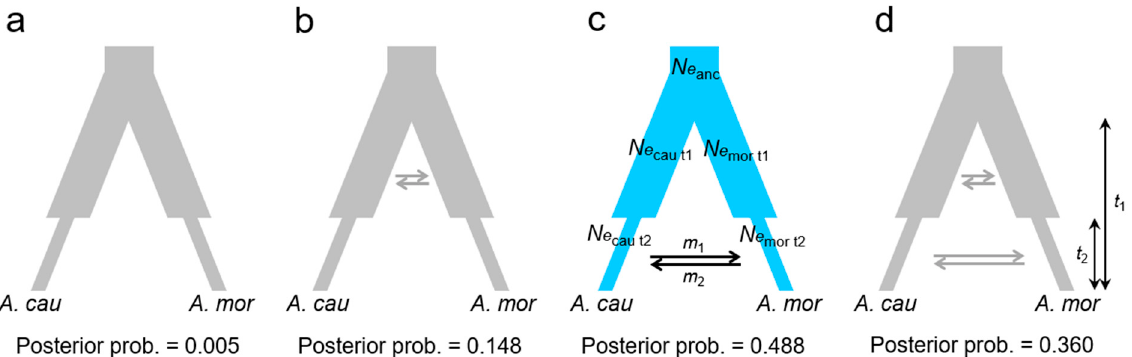
Figure 3. Four evolutionary scenarios describe all possible situations of interspecific gene flow after species divergence, including ( a ) no gene flow ( SI ), ( b ) early ( AM ), and ( c ) recent interspecific gene flow ( SC ), and ( d ) continuous gene flow after speciation ( CM ). The branch thickness represents the effective population size ( N e ) in the recent ( t 2 ), early ( t 1 ), and of the most recent common ancestor (i.e., the uppermost part where the branches converge). Horizontal arrows indicate the direction of gene flows from Acer caudatifolium to A. morrisonense ( m 1 ) and the opposite direction ( m 2 ). Model parameters N e and m denote the effective population size and migration rate. In these scenarios, two species diverged at t 1 ago, and their population sizes were allowed to change at t 2 , the time of stopping interspecific gene flow in ( AM ) scenario or starting to gene flow in the ( SC ) scenario. Abbreviations of four scenarios: ( SI ): strict isolation, no interspecific gene flow was allowed after species divergence; ( AM ): ancient migration, interspecific gene flow was allowed at the early stage of species divergence; ( SC ): secondary contact, interspecific gene flow was allowed at recent periods; ( CM ): continuous migration, interspecific gene flow was allowed at all times after species divergence.